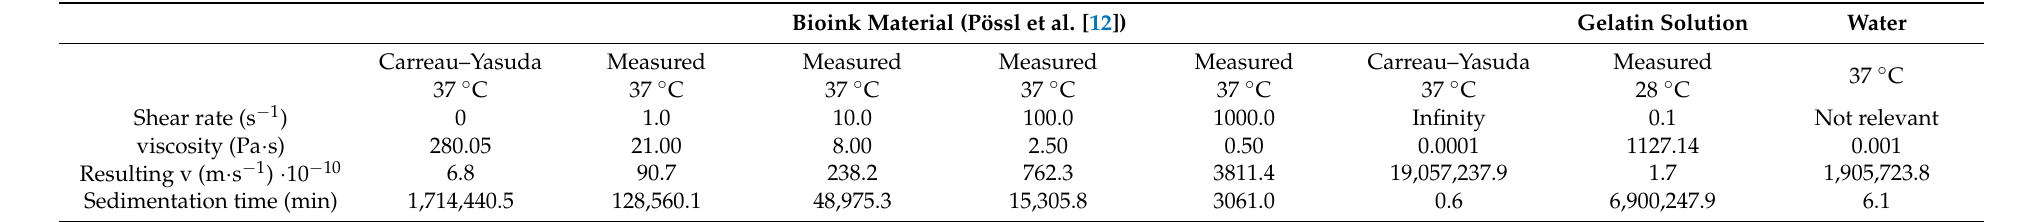
Table 3. Summary of sedimentation times for the carrier material (left), gelatin (middle), and water (right) according to the shear rate, assuming a path length of 7 cm. The temperatures represent the later printing process temperature (37 ◦ C) and the rheological optimization temperature for gelatin (Figure